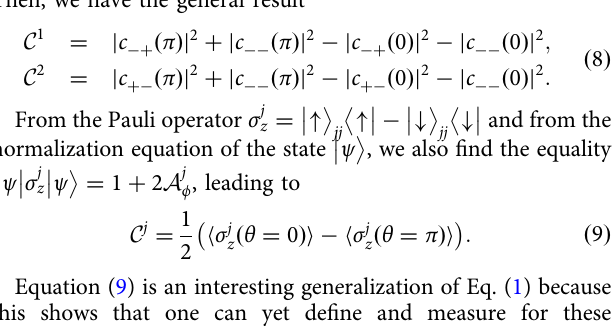
(cid:4) (cid:4) (cid:5) (cid:5) (cid:4) (cid:4) " , is the one 1 2